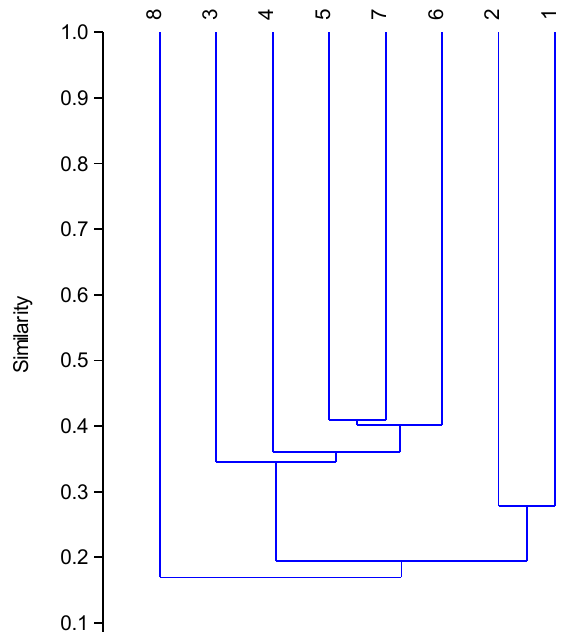
Figure 7. Cluster analysis based on the similarity of ant species occurrence (Jaccard’s Index) in the eight refugium areas of the IP, all of them showing significant differences ( p ≤ 0.01; Refugium areas 1. Cantabric; 2. Pyrenean; 3. Mediterranean coast; 4. Atlantic; 5. Northern plateau; 6. Southern plateau; 7. Guadalquivir Valley; 8. Ebro Valley).